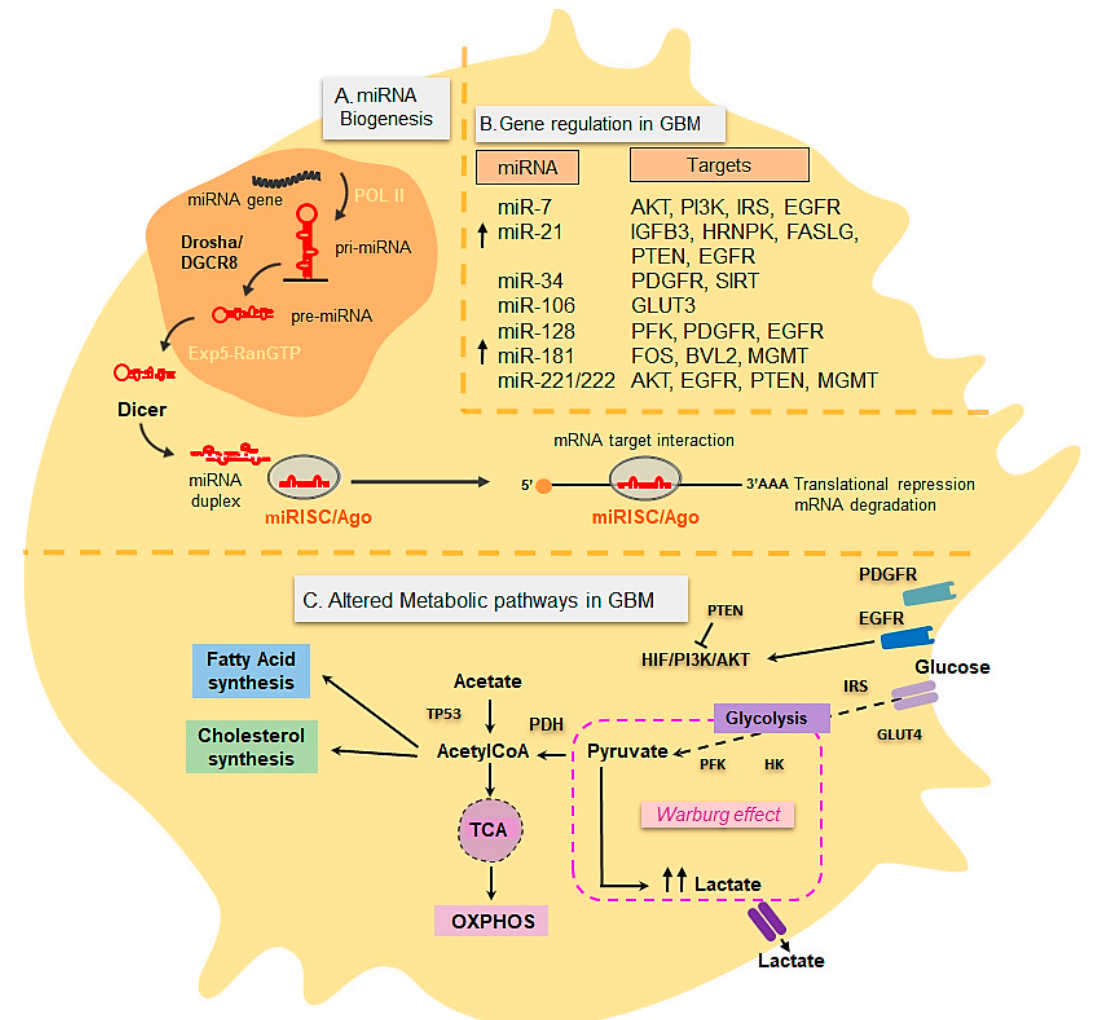
Figure 2. Representation molecular mechanisms underlying the tumoral properties of glioma cells. A. Canonical pathway for miRNA biogenesis. miRNA are transcribed by RNA Pol II to produce the pri-miRNA that is later processed by the endonuclease Drosha/DGCR8 complex resulting in the formation of the hairpin precursor (pre-miRNA) that goes under a second cleavage by the endonuclease Dicer and generates a miRNA duplex. One of the strains, the mature ~22 nt (guide strain) is later loaded into the RISC (RNA Induced Silencing Complex) in association with Ago proteins. Via imperfect base-pairing to the 3 ′ UTR of its target mRNAs, miRNAs regulate the expression of its target genes by repressing mRNA translation and/or promoting mRNA degradation. B. miRNAs and target genes involved in GBM. Examples of miRNAs found to be downregulated or upregulated (indicated with the arrow) in GBM and their target genes involved in GBM pathology. C. Metabolic pathways altered in GBM. Metabolic switching towards aerobic glycolisis is a hallmark of cancer which controls the properties and functions of tumor cells, such as their increased proliferation or resistance to treat- ments. The therapeutic intervention of metabolic pathways, described in this figure, may offer new opportunities for the treatment of GBM.